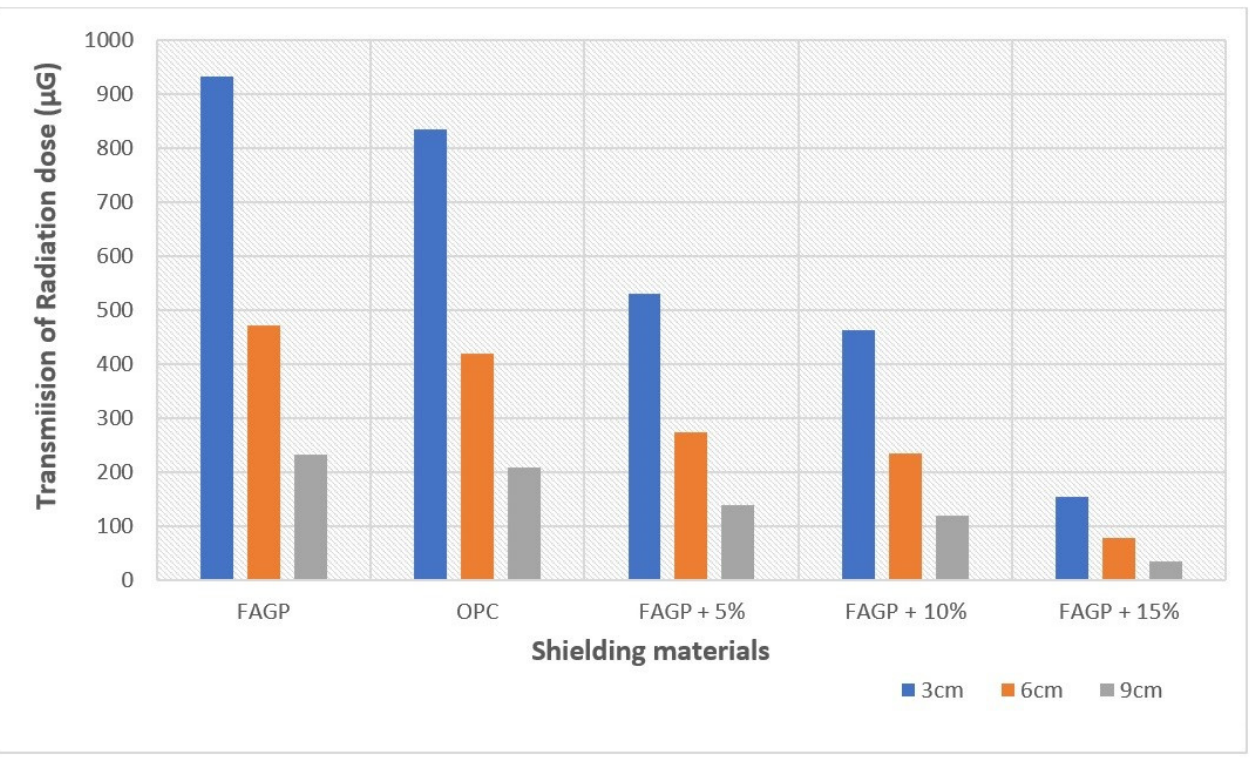
Figure 4. A diagram showing the differential dose absorption through OPC and different thicknesses of FAGP.